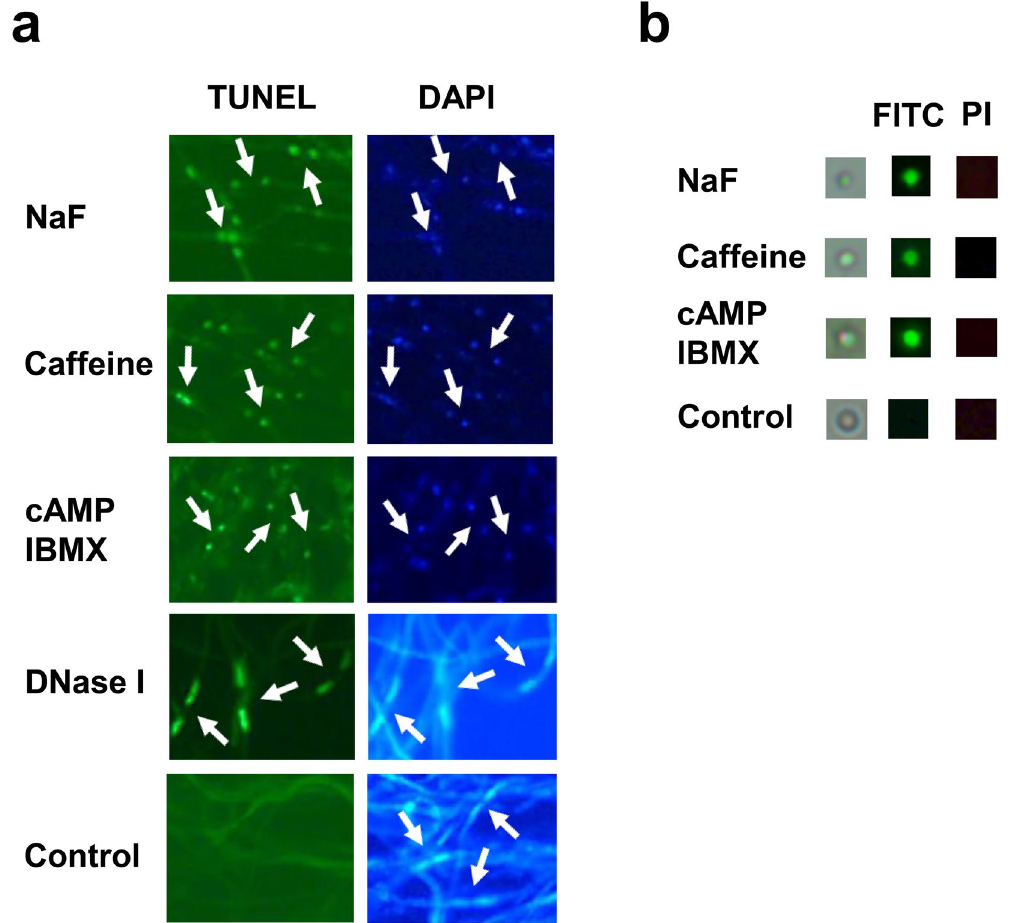
Figure 1. Apoptosis induction in Ganoderma lucidum . Fungal mycelium was incubated with 20 mM NaF, 80 mM caffeine, or 40 mM cAMP/15 mM IBMX for 16 h prior to staining. ( a ) DNA fragmentation was assessed by TUNEL assay. DAPI staining was used to locate the nucleus and assess the nuclear morphology of the fungal cells. The arrows indicate the two nuclei present in each fungal cell. Untreated fungal cells did not show any fluorescence signal in the TUNEL assay. To further confirm the relevance of the nuclear morphology of the fungal cells, mycelium was pretreated with DNase I to induce DNA breaks and then subjected to TUNEL assay and DAPI staining. ( b ) Isolated protoplasts were stained with FITC-conjugated annexin V and propidium iodide